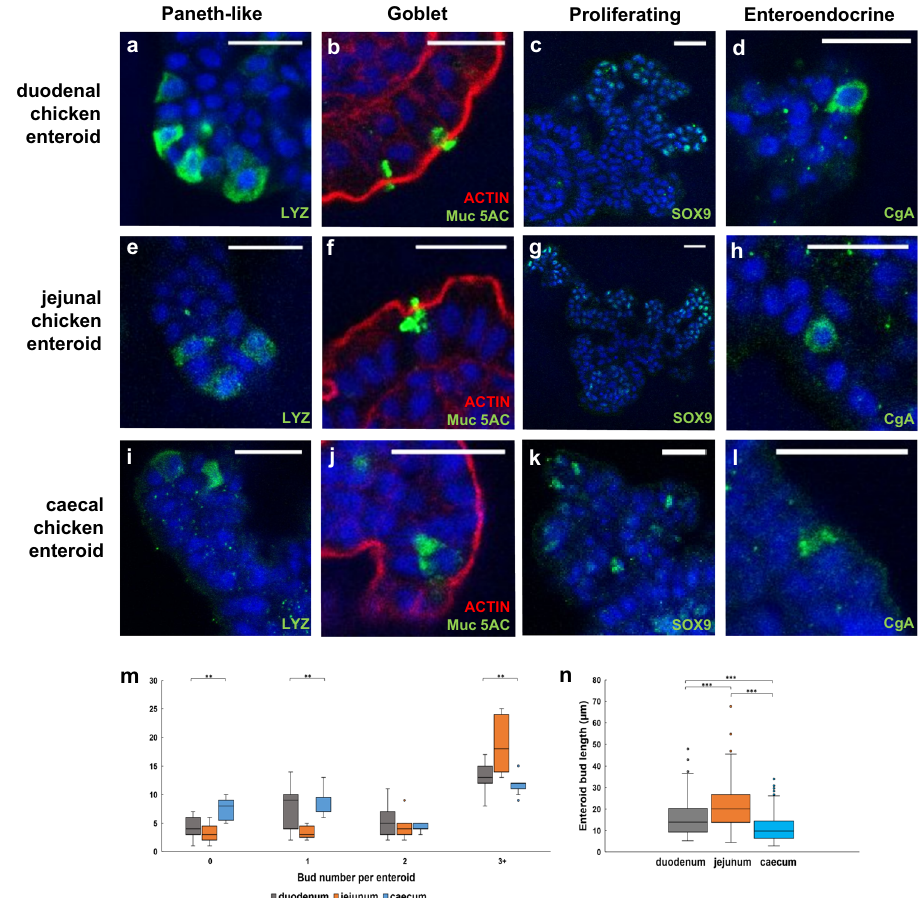
Fig. 4 Site-speci fi c chicken enteroids demonstrate in vivo multicellular composition and architecture. a – l Confocal images of embryonic chicken enteroids at 2 days of culture grown from the duodenum, jejunum and caeca. Stained for a , e , i Lysozyme C (green, Paneth cells), b , f , j Muc5AC (green, goblet cells), c , g , k Sox9 (green, proliferating cells), and d , h , l Chromogranin A (green, enteroendocrine cells). All counterstained with DAPI (blue). b , f , j stained to detect F-actin-expressing brush border (red). Scale bar: 20 µ m. Images are representative of data from at least 3 independent cultures, each containing 2 – 3 embryos. m Enteroids were cultured for 2 days and the number of villus-crypt like structures or buds, i.e. 0, 1, 2, 3 or more per enteroid, were counted. After 2 days of culture there were statistically signi fi cant differences in numbers of buds between the different regions of the small intestine. The caecal enteroids more often lack buds (0) or only have 1 bud compared to duodenal and jejunal enteroids, whereas jejunal enteroids have more buds (3 + ) in comparison to duodenal and caecal enteroids. n The length of the buds resembled the in vivo architecture with jejunal and duodenal buds measuring signi fi cantly longer than caecal buds. Box and whisker plot data derived from 3 independent experiments each containing 2 – 3 embryos, at least 260 enteroids and 150 buds measured per location for m and n , respectively. Statistics performed using a Kruskal – Wallis test; m 0 budding, ** p 0.001, H = 14.06, df = 2; 1 budding, ** p 0.001, H = 13.42, df = 2; and more than 3 budding, ** p 0.001, H = 13.62, df = 2, enteroids between the duodenal, jejunal and caecal cultures. n *** p 0.0001, H = 110.08, df = 2, with post hoc Mann – Whitney U -tests (two-sided); duodenum – jejunum, *** p 0.0001, W =